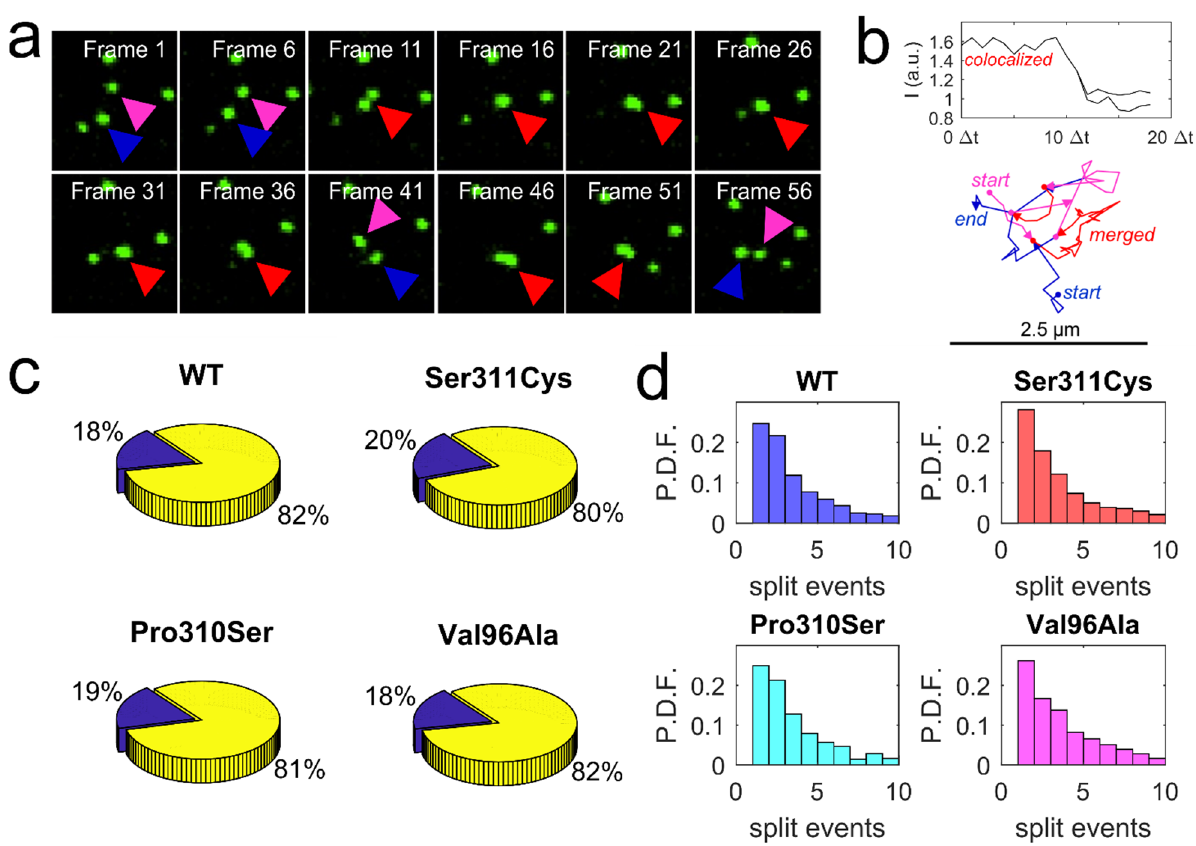
Figure 4. Detection of merging and splitting events in Qdot-D2L trajectories. ( a ) A representative time-lapse series shows two separated Qdots (blue and magenta arrows) transiently merging into a single spot (red arrow) with higher total intensity. ( b ) An example intensity profile of an observed merged (colocalized) Qdot spot splitting into two separate trajectory segments (top; ∆ t = 0.1 s); a representative reconstructed trajectory containing a merged (red) track segment is shown here. ( c ) Three-dimensional pie charts show a fraction of trajectories undergoing merging and splitting (blue wedge) for each D2L coding variant tracked (438 out of 2483 tracks with more than 50 detected spots in length for WT; 611 out of 3468 tracks (>50 spots in length) for Val96Ala; 493 out of 2659 tracks (>50 spots in length) for Pro310Ser; 797 out of 3944 tracks (>50 spots in length) for Ser311Cys; n = 10 movies acquired at 30 Hz for 2000 frames and previously used for diffusion rate analysis). ( d ) Histograms of the number of splitting events per M&S-positive trajectories identified in ( c ) are shown here.